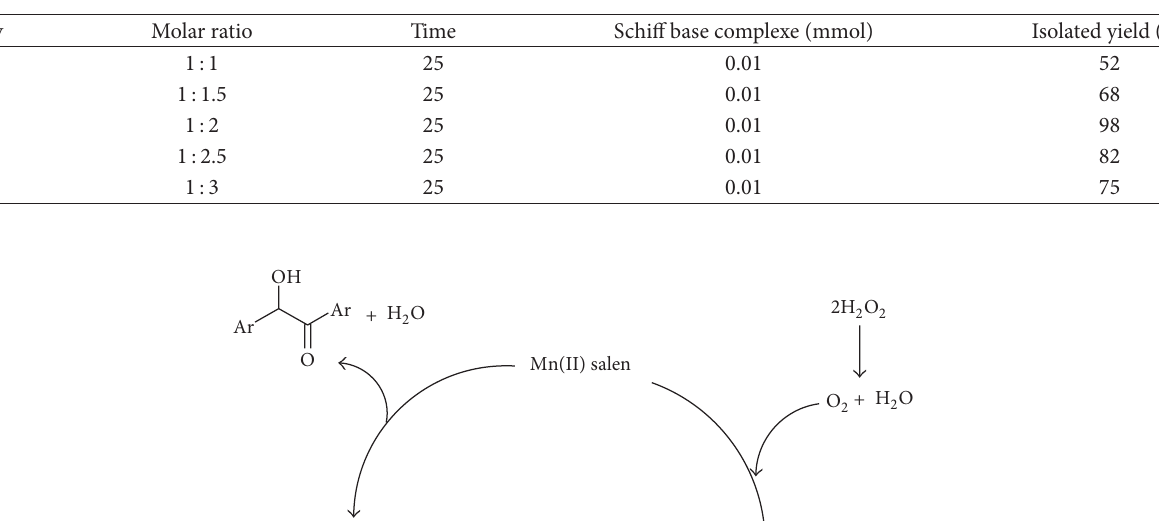
T 1: e effect of reaction conditions on the oxidation of benzoin in the presence of Mn(II) Schiff base complex in CH temperature.